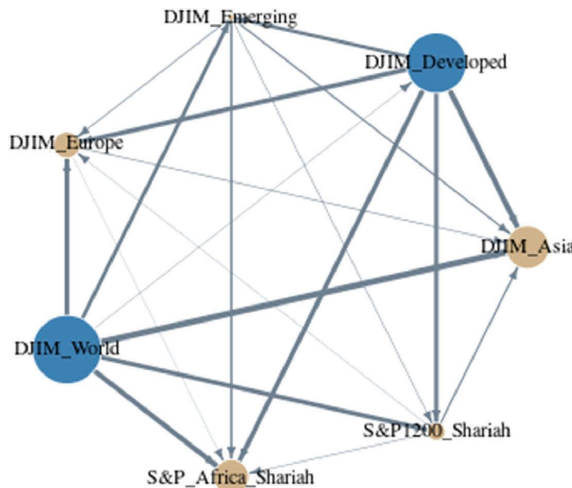
Figure 2: Static pairwise connectedness between regional Shariah markets. Notes: with a one-way direction arrow, arrows represent the net directional connectivity between two variables in the system. Blue (brown) nodes illustrate the net transmitter (receiver) of shocks. Vertices are weighted by averaged net pairwise di- rectional connectedness measures. Te size of nodes represents the weighted average net total directional